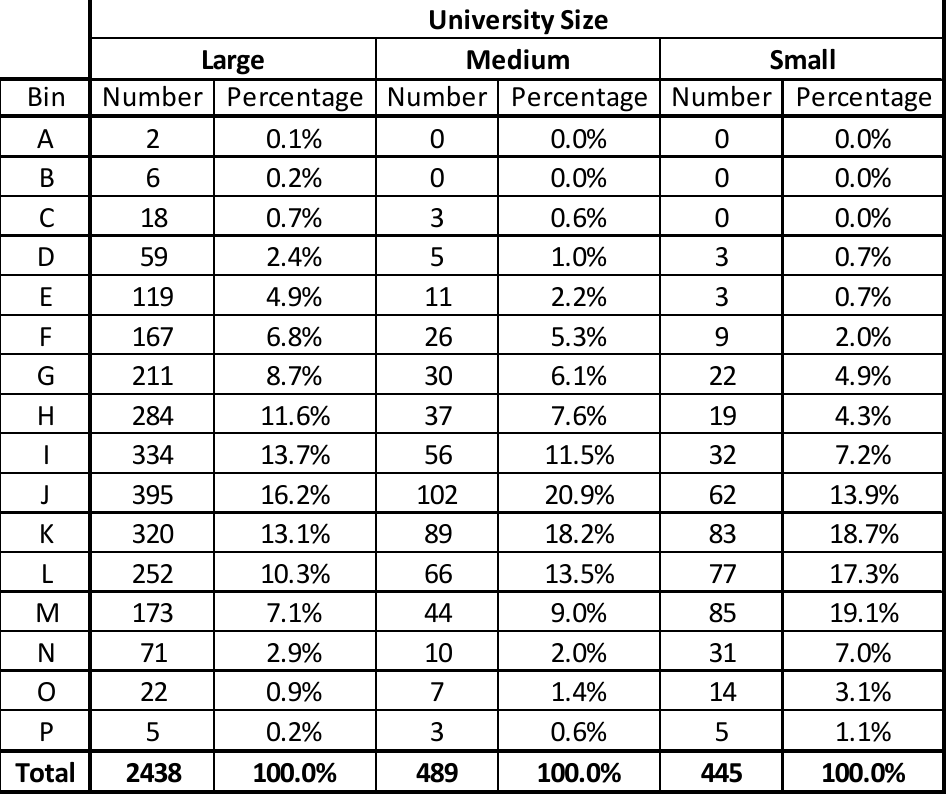
Number of Applications by Quality Bins by University